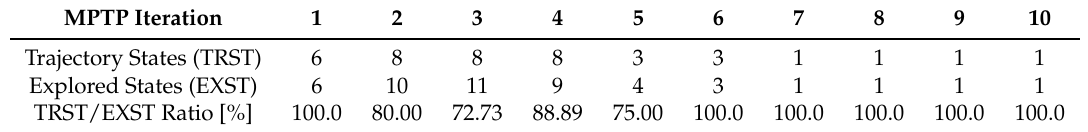
Table 18. A* with SSPH applied to the avoidance in Figure 12, if the aircraft can turn left and right. MPTP Iteration